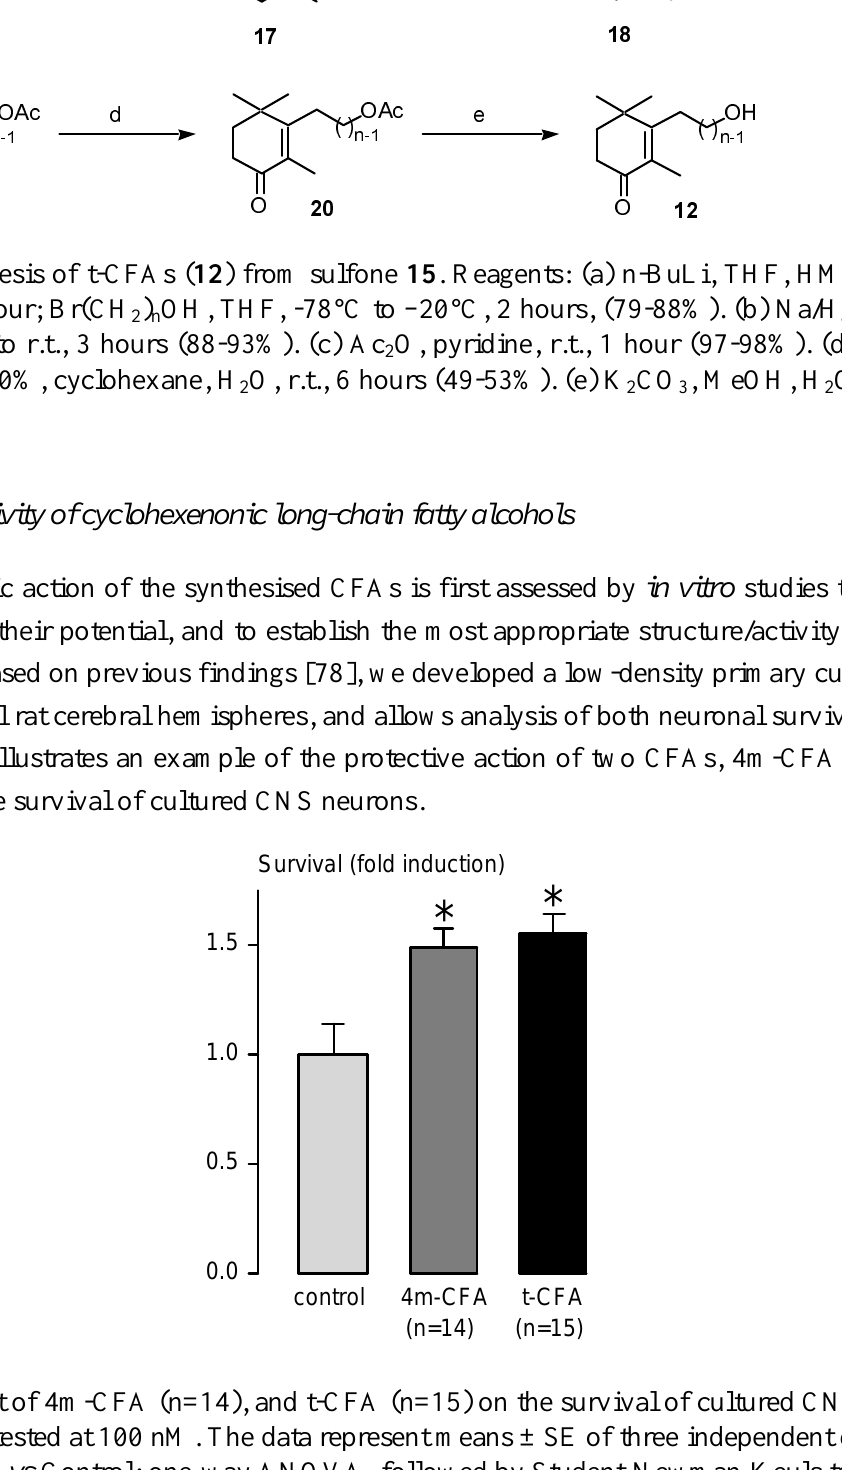
, - 3 0.7% 3 CO , MeOH, H O, r.t., 2 hours 2 3 2